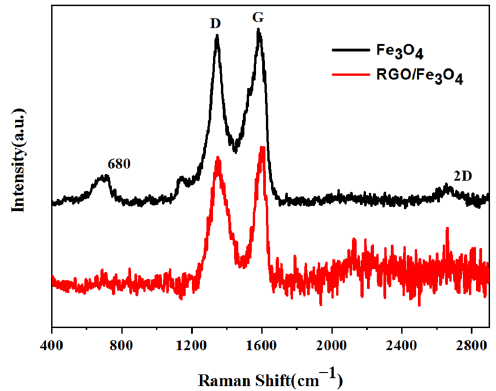
Figure 5. Raman spectra of GO and RGO/Fe 3 O 4 nanocomposite.